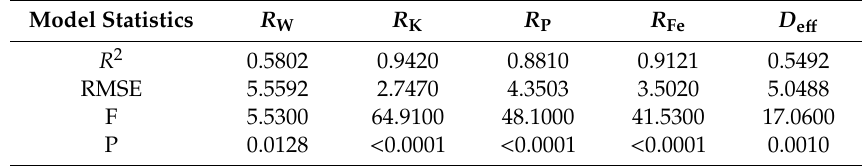
Table 4. Summary of fit (actual vs. predicted) for the five studied responses for the Falcon UF.